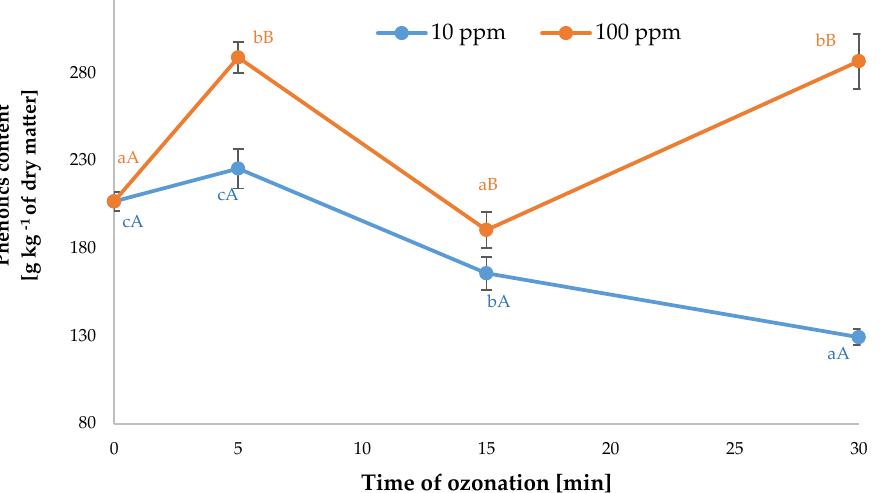
Figure 7. Total polyphenolic content in Rheum rhaponticum L. petioles, depending on the duration of ozone treatment (n = 3) . The differences in the results between the ozonation time for individual variants are marked with different small letters, and the difference between the measurement values for the tested variants is marked with different capital letters, p < 0.05.